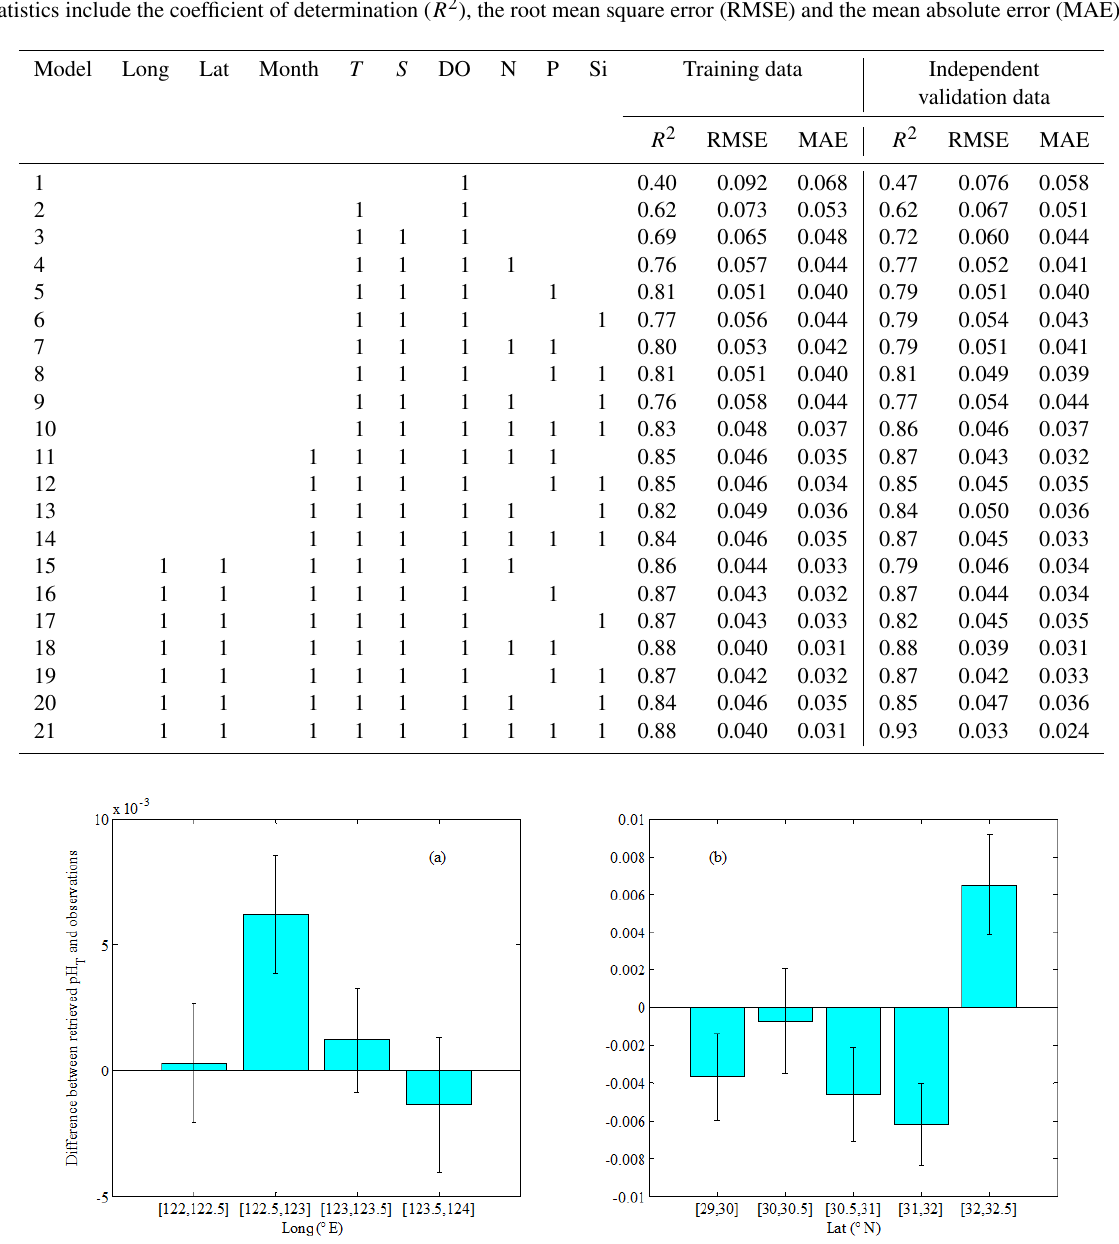
Figure 7. Box plots of the differences between retrieved pH T and the observations. (a) The differences vs. longitude (mean ± SE); (b) the differences vs. latitude (mean ± SE). The height of each box represents the mean value of the differences; the whiskers represent the standard error (SE) value of the